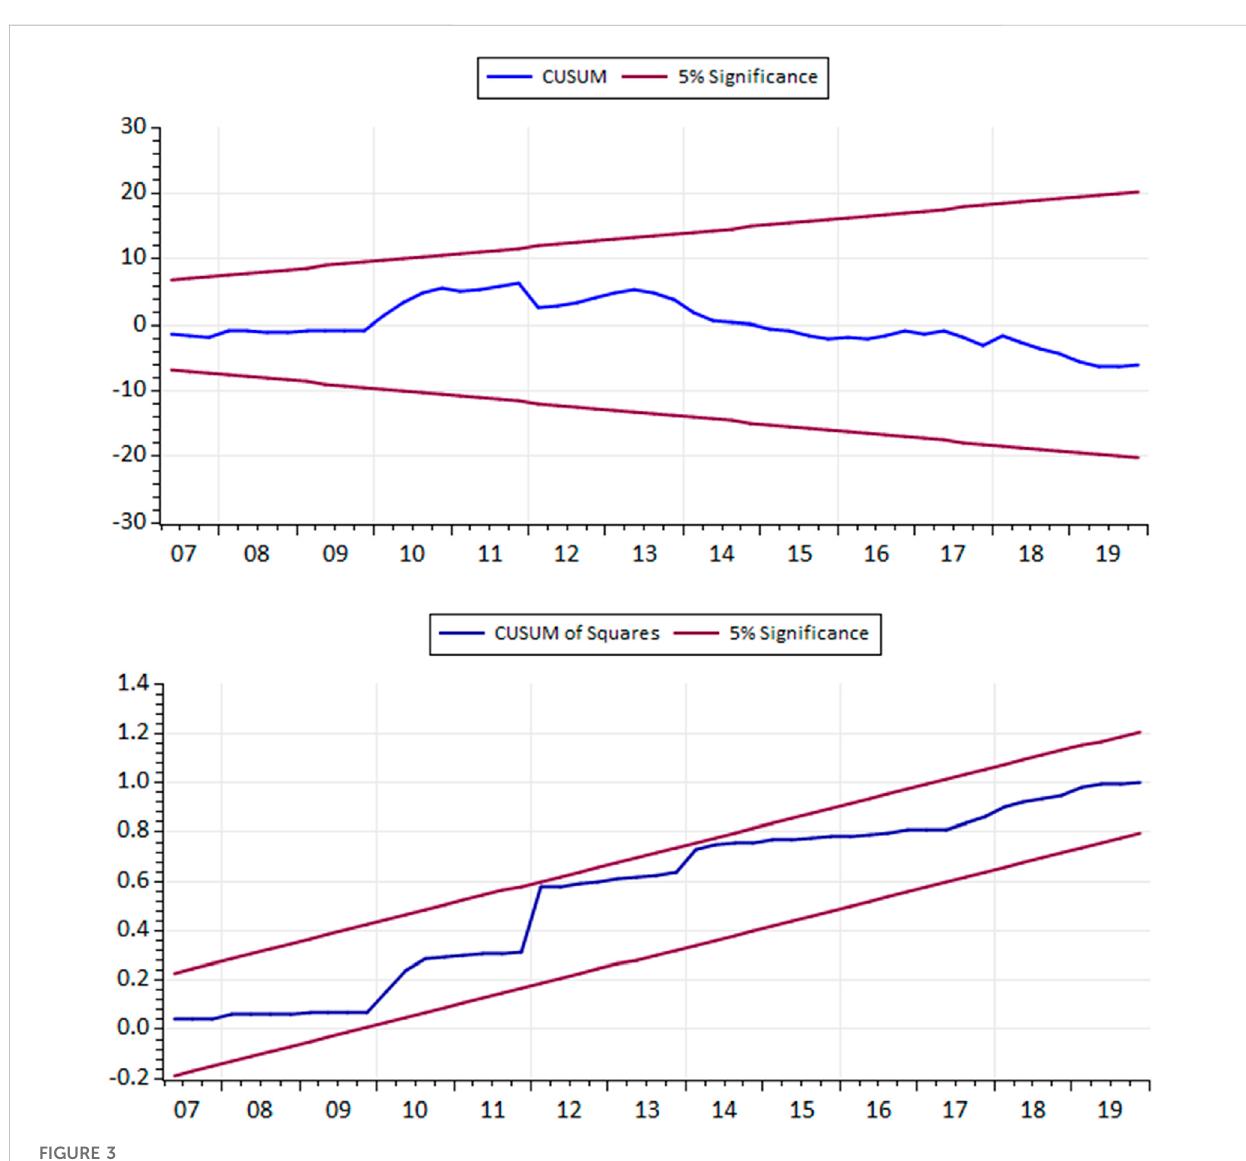
FIGURE 3 CUSUM and CUSUMSQ graph with a 5% level of signi fi